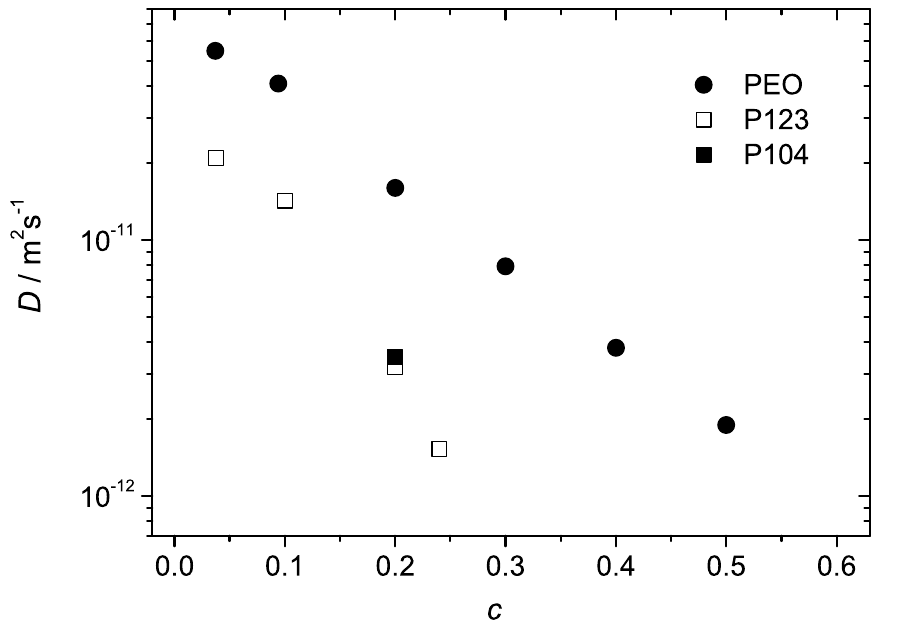
Figure 3. The diffusion coefficients of polymer molecules in the samples P123, P104 and PEO in water as a function of polymer concentration at T = 23 ◦ C. The range of concentrations for P123, P104 is limited to the micellar phase. The data points are evaluated from the spin-echo diffusion attenuations shown in Figure 2. In the case of PEO and P123 they refer to mono-exponential fits. In the case of P104 the data point was evaluated from the initial slope of the curve and represents the average